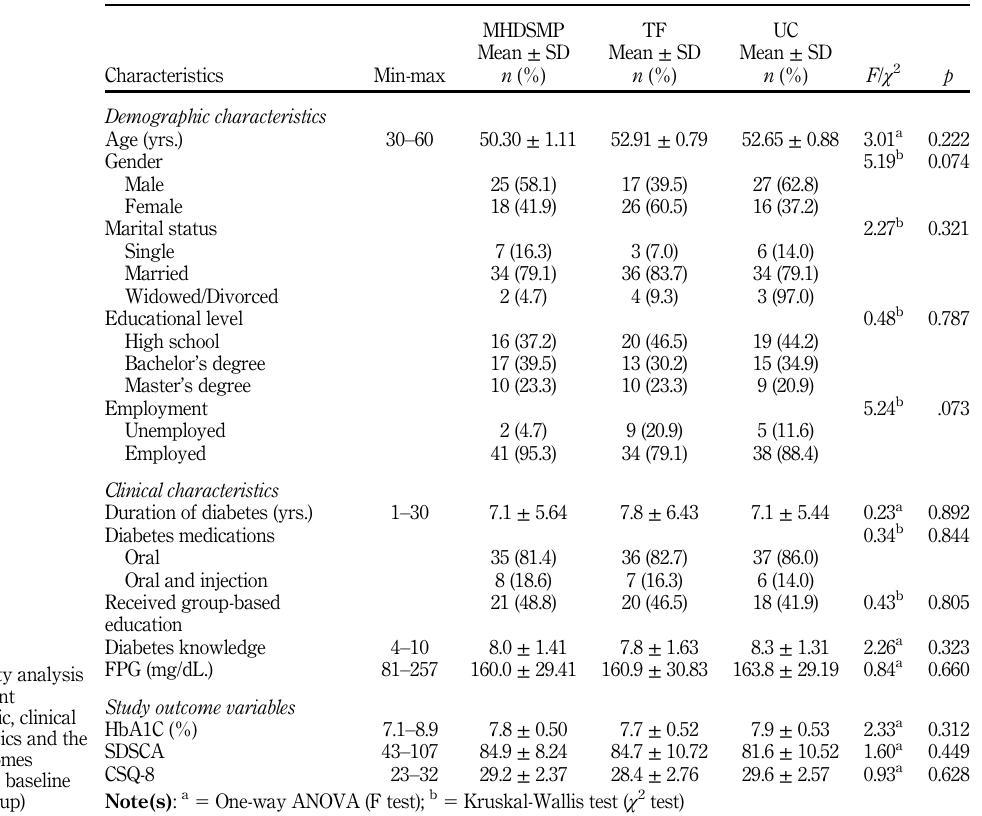
Table 2. Homogeneity analysis of participant demographic, clinical characteristics and the study outcomes variables at baseline ( n 5